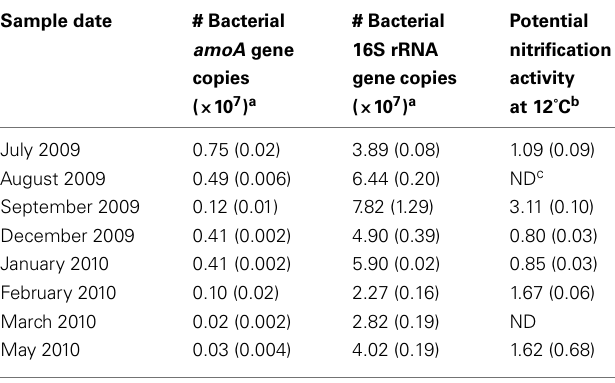
Table 2 | Relative abundances of bacterial amoA genes and potential nitrification activity in the retention pond water by